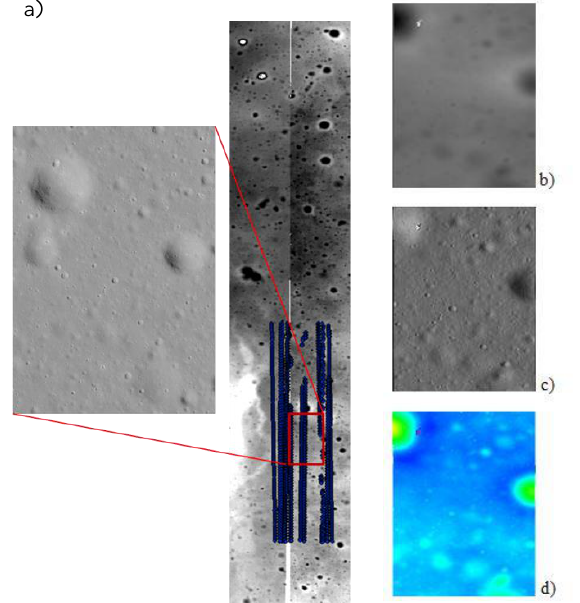
Figure 10: a) On the right side: the DTMs produced by ASP overlaid by the LOLA tracks (just those that fall into the region interested by the Vicar DTM) are shown. On the left: the zoomed area of the region covered by either the DM-ASP DTMs and LOLA data. b) Disparity map DM DTM, c) Hillshaded DM DTM, d) Colour coded image of the elevation The comparison between the stereo DTMs and the laser altimeter data is delicate because the spatial resolution of the datasets are very different. As far as LOLA is concerned, the distance between the shots of each profile (one of the five that compose the parallel profiles along LRO’s sub ‐ spacecraft ground track) is separated by ∼ 56 m and the diameter of the spot is 5 meters (Smith, 2010). The spatial resolution for stereo imaging is higher Table 1: Comparison results using different shape function and and depends directly on the image resolution ( ∼ 60 cm for NAC different template size in the SVS test. acquisitions).